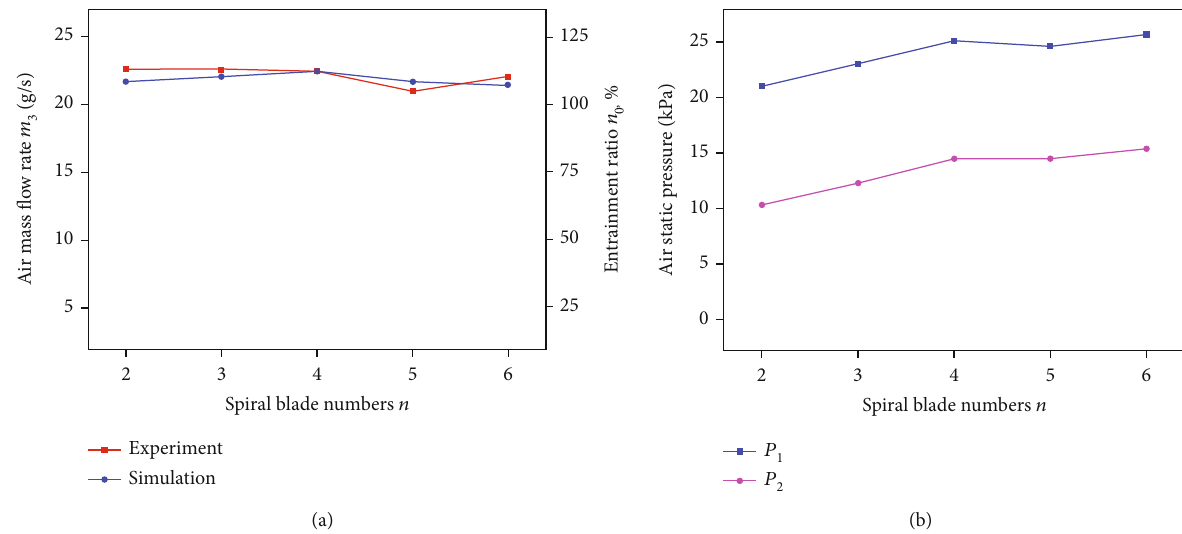
Figure 11: Relationship between number of spiral blades and entrainment performance of drill bit without fl ushing nozzles: (a) entrainment performance; (b) static